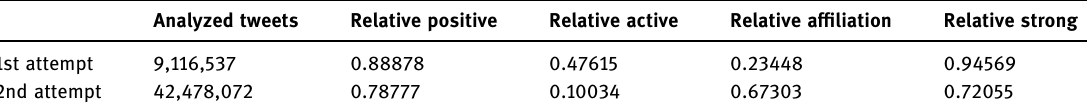
Table 4: F - statistics for the hypothesis H 0 : the S&P 500 returns do not Granger cause the change in sentiment Analyzed